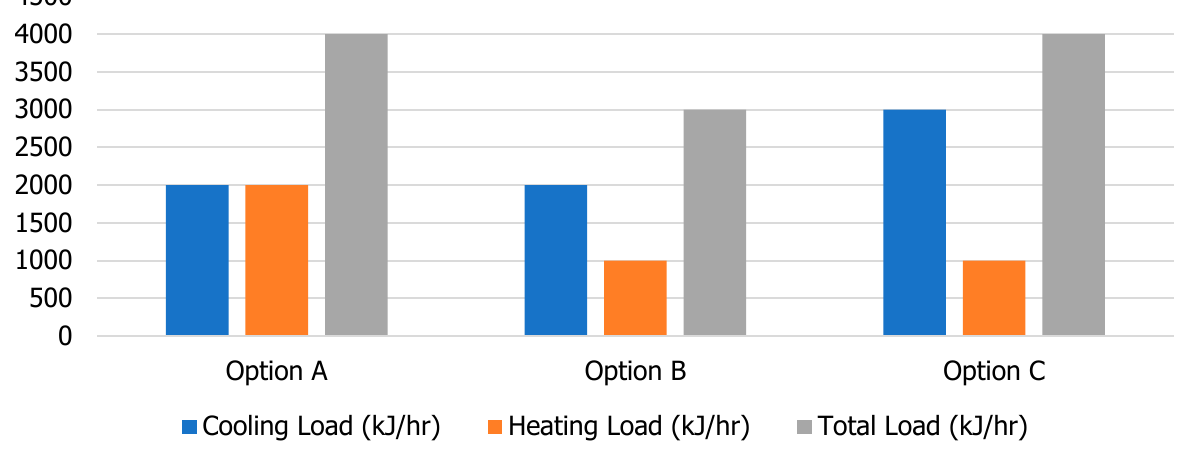
Figure 31. Overall load comparison.